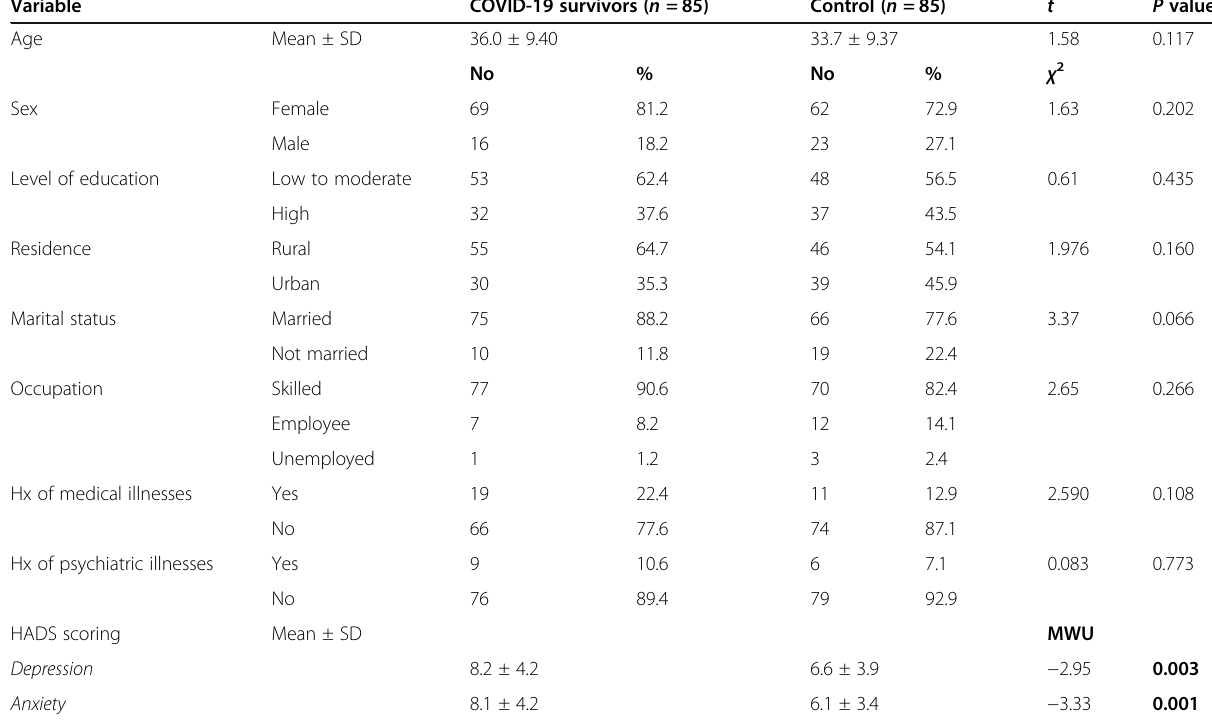
Bold text indicates statistical significance where P value <